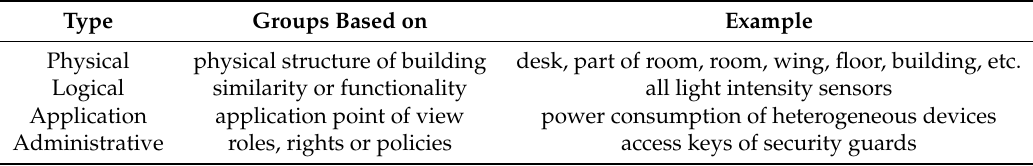
Table 1. Potentially relevant types of resource grouping in Building Automation Systems